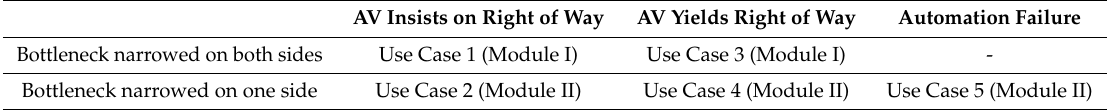
Table 2. Five di ff erent Use Cases the participants passed